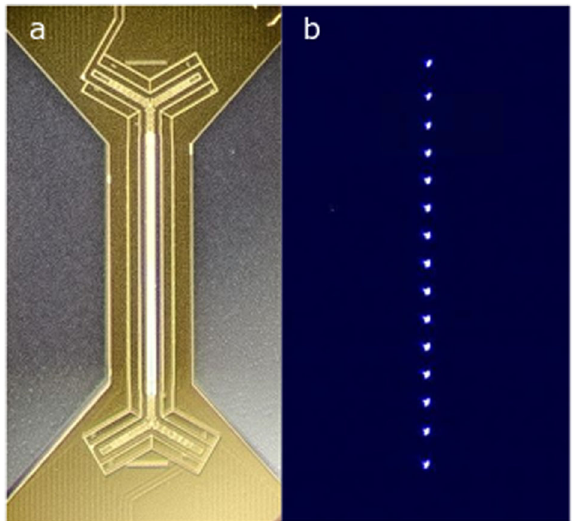
Fig. 2 Quantum processor. a A micro-fabricated surface electrode ion-trap, which is used to trap a linear chain of Ytterbium ions. b A chain of 15 ions is imaged by collecting fl uorescence using an optical microscope, where each ion can represent a physical